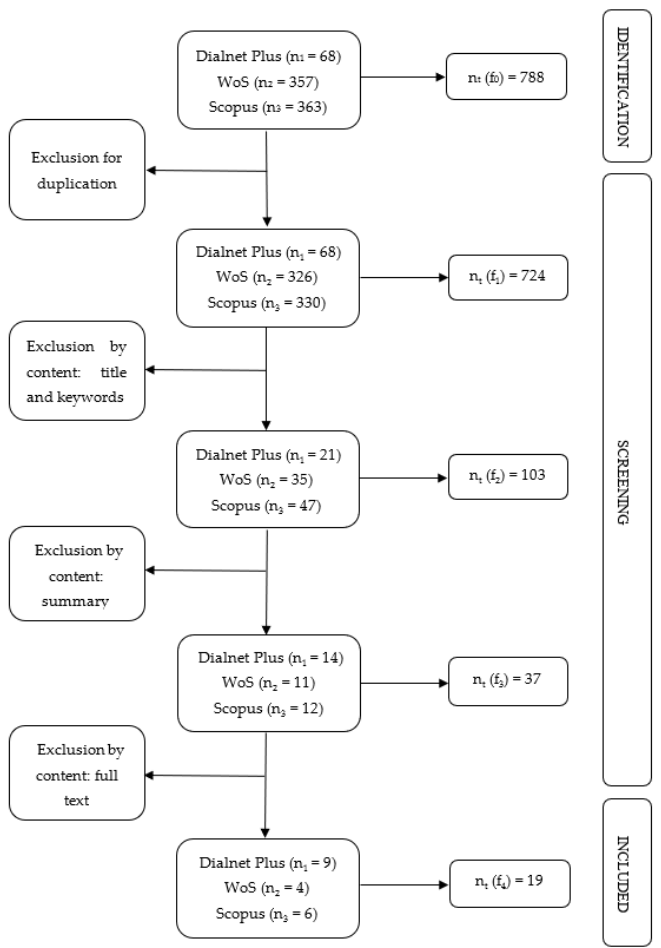
Figure 1. Flow chart of the selection process. Own elaboration based on PRISMA protocol. The database search found 788 initial papers that met the selection requirements. After Table 3. Characteristics of the selected documents. discarding duplicates, 724 documents remained. Taking into account the inclusion and exclusion criteria indicated above, 103 references were left out after reading the titles and keywords. The same criteria were applied to select the remaining documents based on the content of the abstract. Finally, 37 references were subjected to full-text analysis applying the same criteria, leaving 19 resulting documents (Table 3): 11 articles (57.9%), 5 books (26.3%), 2 chapters (10.5%) and 1 thesis